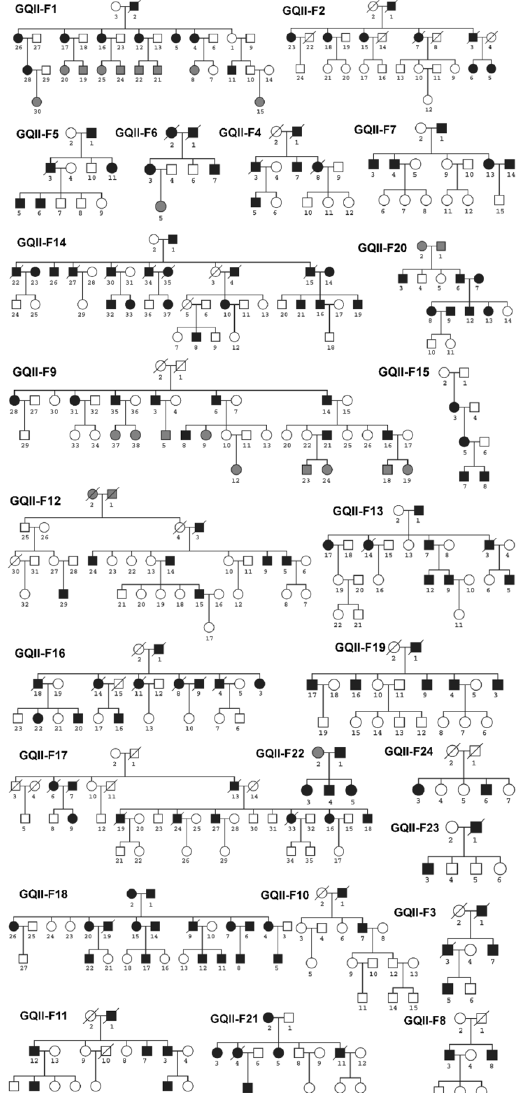
Figure 1. Pedigrees of 24 GeneQust II families. Unaffected subjects were shown as clear circles (females) or squares (males), and affected subjects were shown as solid symbols. Subjects with uncertain phenotypes were shown in gray color. The deceased subjects were marked by a slash symbol.